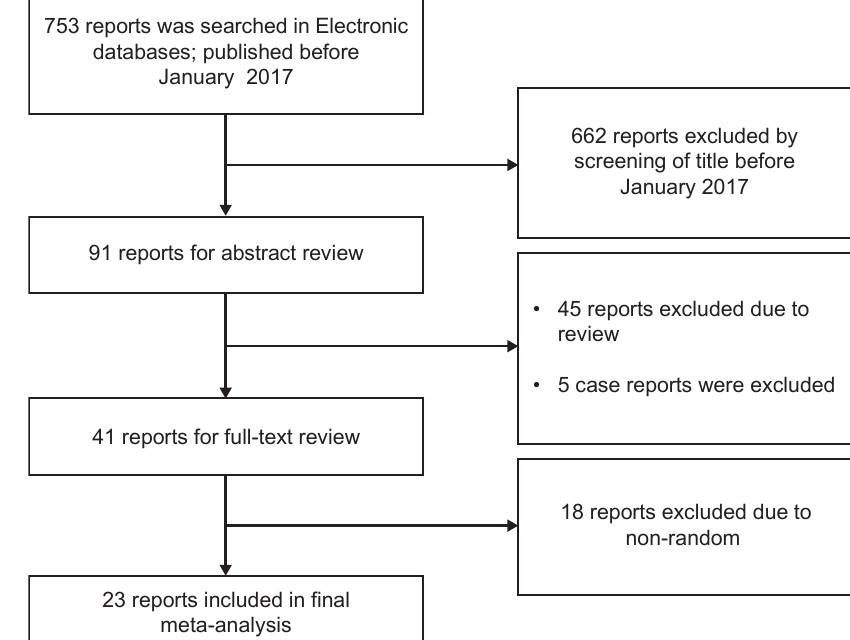
Figure 1. Flow chart of eligible